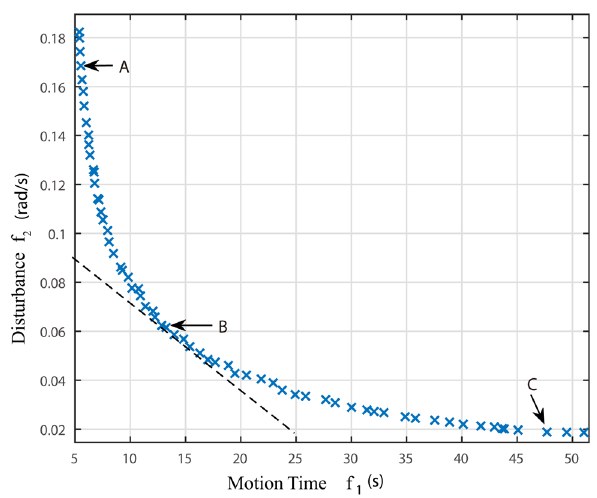
Figure 7: Distribution of non - dominated solutions.